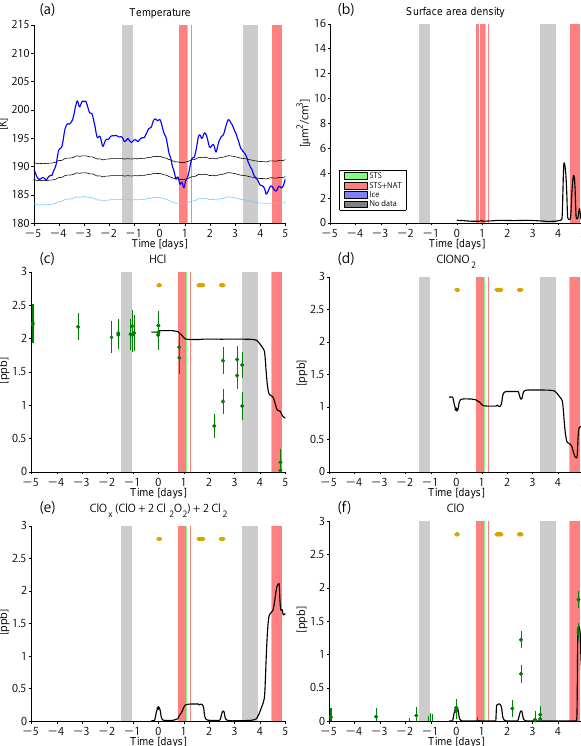
Figure 13. Same as Fig. 8 but for trajectory case no. 09, starting at 18:35:15UT on 31 December 2009 at an altitude of